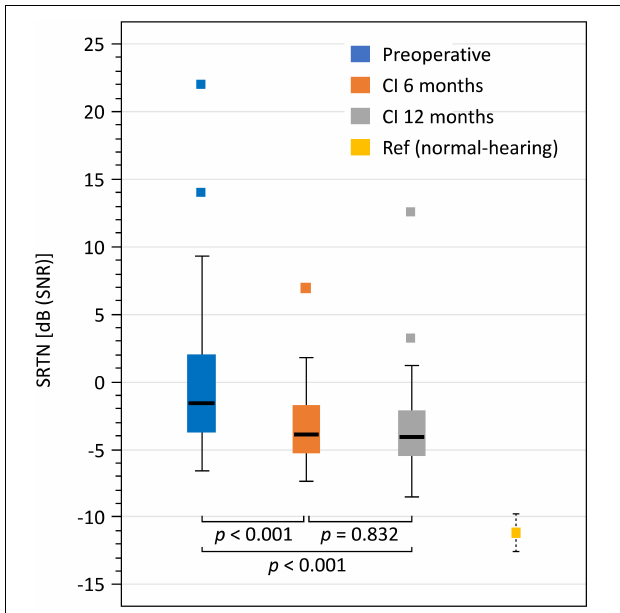
FIGURE 1 | Boxplots for preoperative, 6 and 12 months SRTN including normal-hearing reference mean and 95% confidence interval.